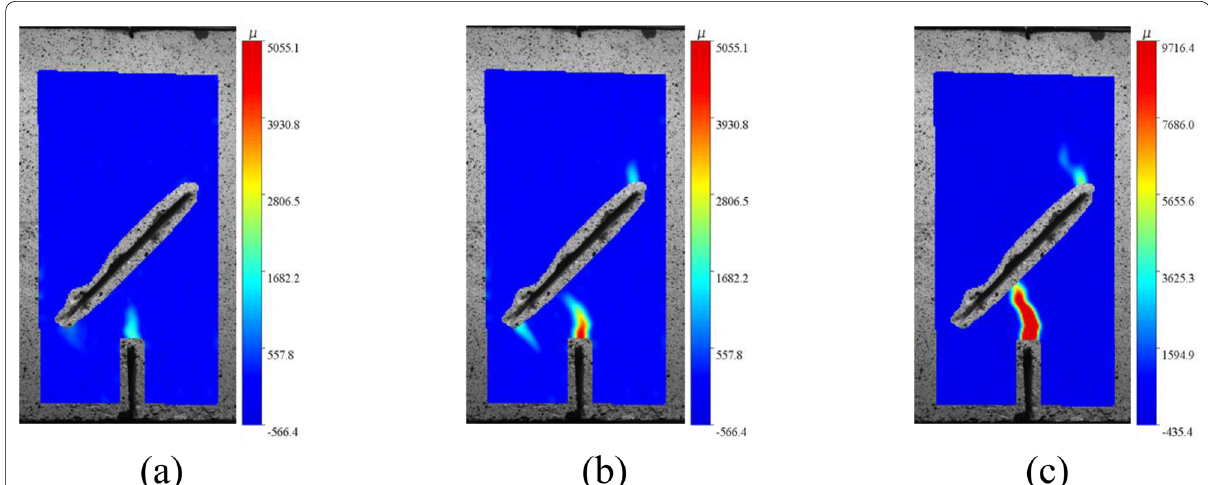
Fig. 9 Evolution of the principal strain field of TPB‑A45‑T2 during the fracture processes: ( a ) crack initiation, ( b ) crack intersection, and ( c ) instability stage